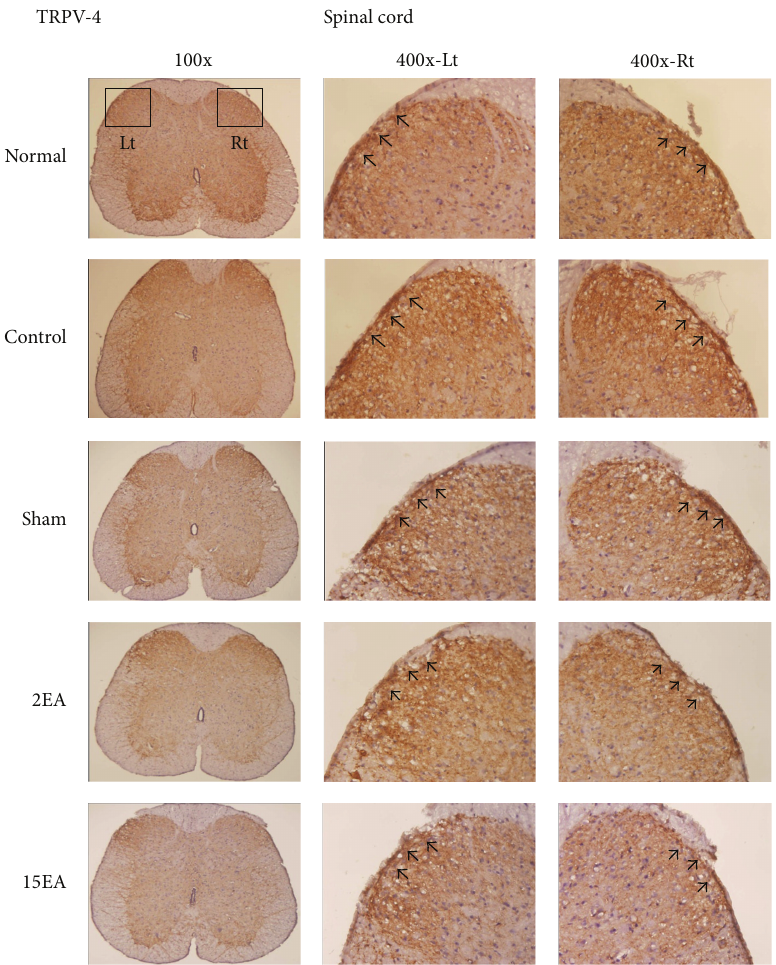
Figure 4: Effect of EA on spinal TRPV4 immunostaining positive cells in SD rats with CCI-induced neuropathic pain. TRPV4 immunostaining positive cells (arrow) in the spinal cord (Spinal cord) for the normal group (Normal), control group (Control), sham group (Sham), 2EA group (2EA), and 15EA group (15EA) were similar; Lt = left side of spinal cord; Rt = right side of spinal